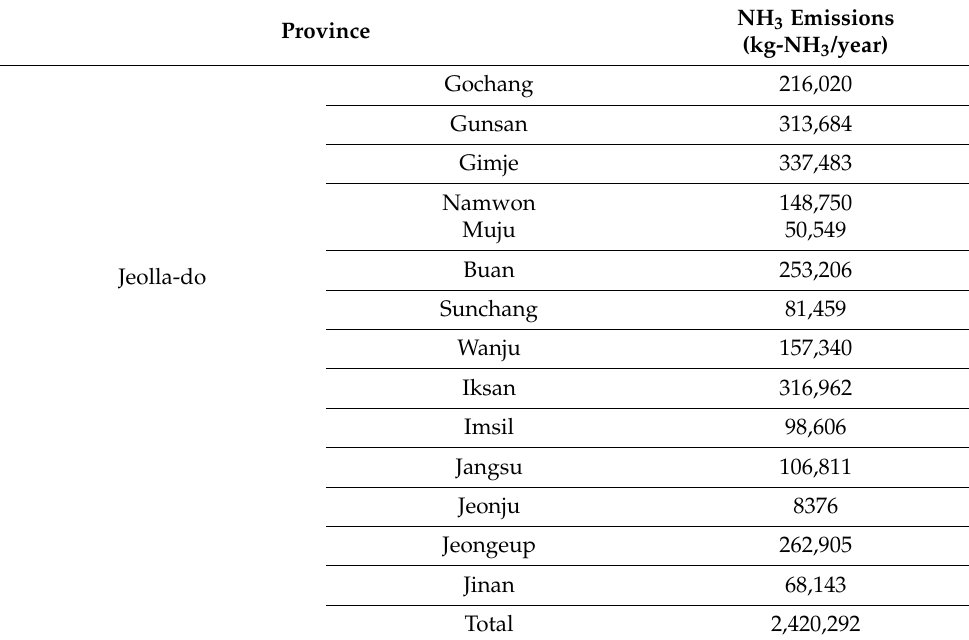
Table 7. NH 3 emissions in Jeolla-do (2017) with Method